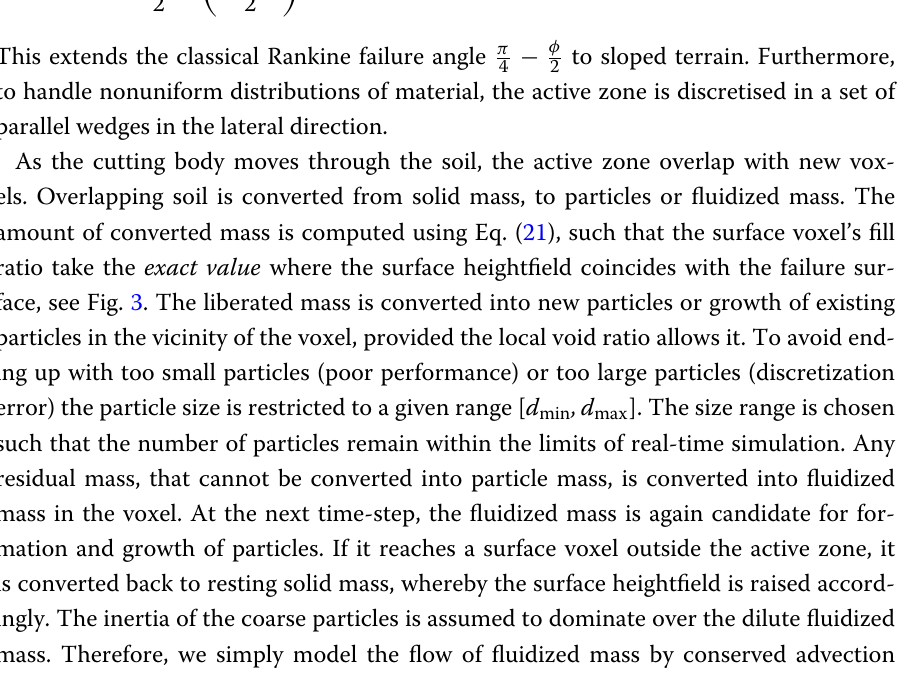
microscale model we identify the following